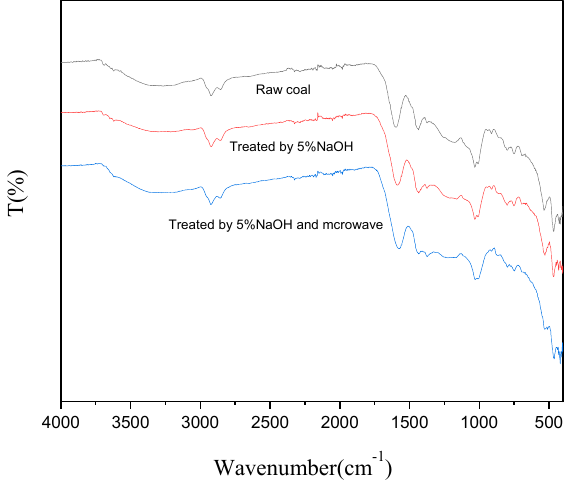
Figure 4. FTIR curves of coal sample treated by different conditions. The FTIR spectra of the coal samples can be divided into four regions: 3600–3000 cm − 1 (meanly ‐ OH groups), 3000–2800 cm − 1 (meanly aliphatic C ‐ H groups), 1800–1000 cm − 1 (meanly O containing groups) and 900–700 cm − 1 (meanly aromatic C ‐ H groups) [24,25]. As shown in Figure 5. The spectrums of three samples were similar on the whole, which meat that the basic macromolecular structure of coal sample were not changed sig ‐ nificantly after treated.